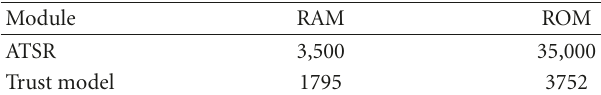
Table 1: Node resources required for the implementation of the trust model and the ATSR block.